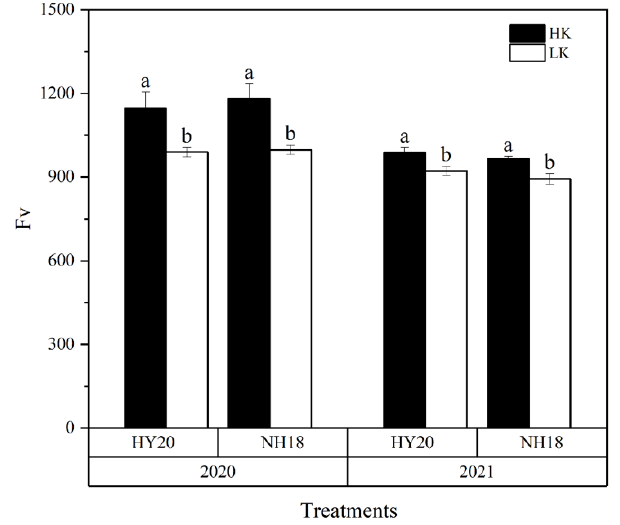
Figure 7. Effects of low K stress on fluorescence parameters of dark adaptation. HK: high K treatment; LK: low K treatment. For the bar chart, a,b indicates a significant difference between different treatments for the same variety( p < 0.05).